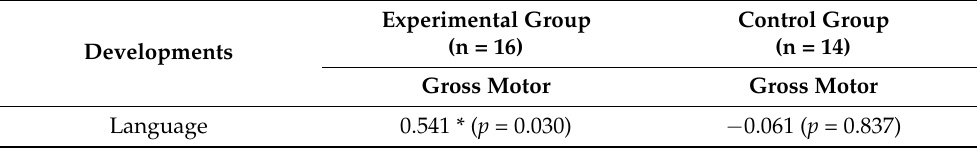
Table 5. Correlation of intra-individual variability between gross motor and language developments.